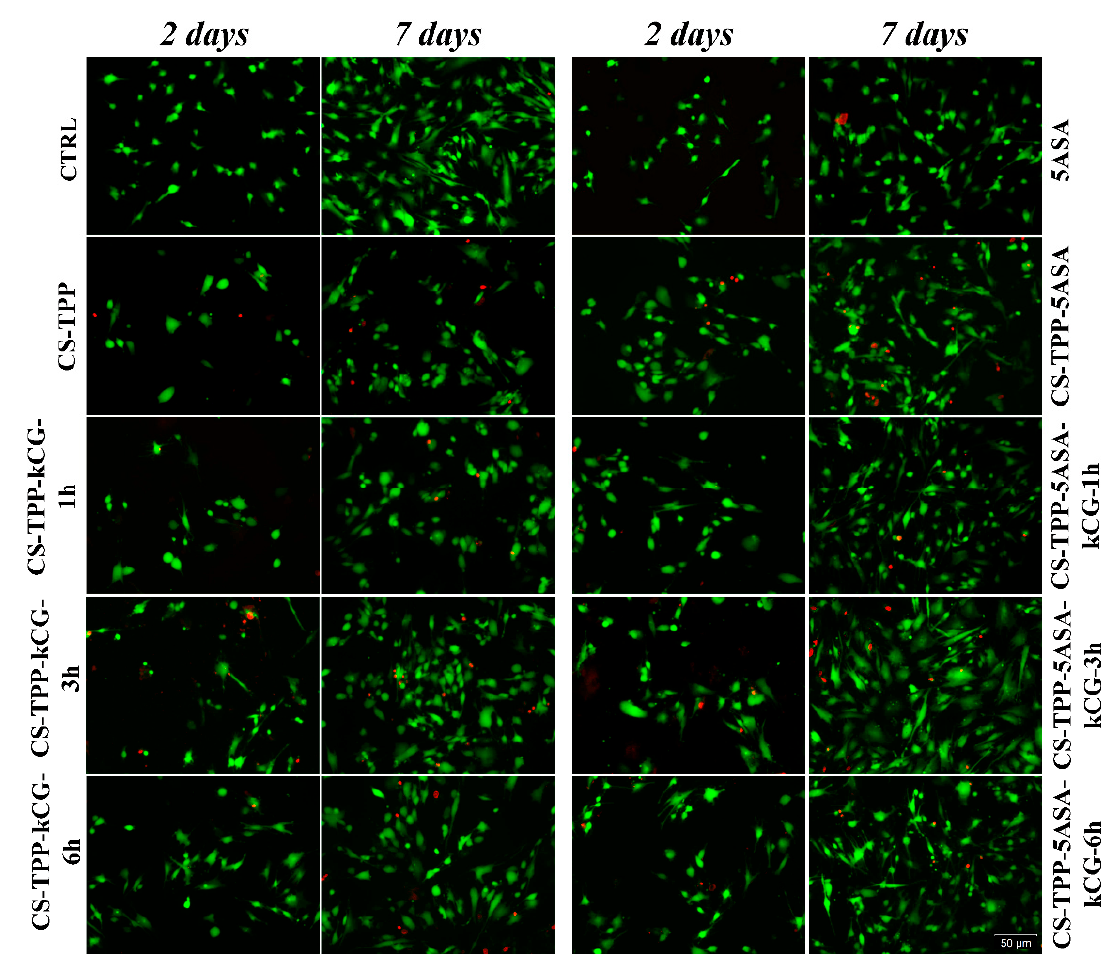
Figure 14. Confocal microscopy of live (green) and dead (red) cells cultured in contact with all of studied particles for 2 and 7 days. Scale bar 50 um.